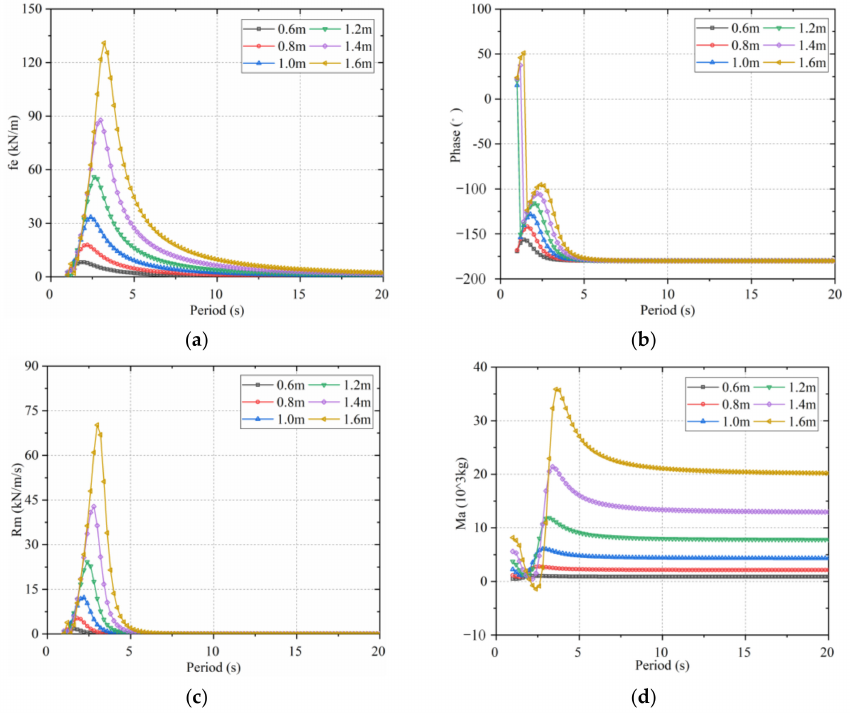
Figure 7. Hydrodynamic parameters at different radius: ( a ) Wave exciting force at different radius; ( b ) Phase shift of wave exciting force at different radius; ( c ) Radiation damping at different radius; ( d ) Added mass at different